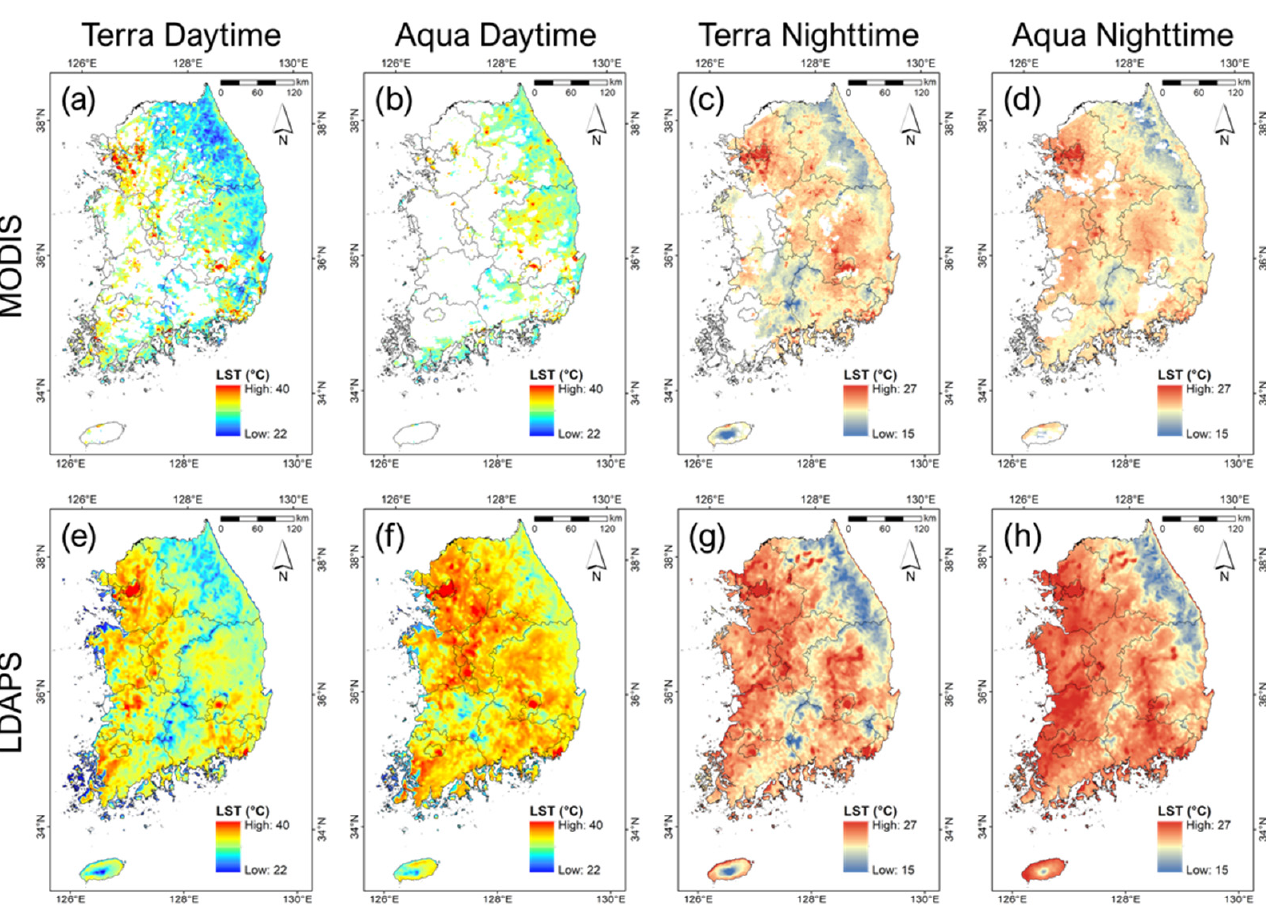
Figure 9. Spatial distribution of 1 km LSTs from ( a - d ) MODIS, ( e - h ) LDAPS, and ( i - l ) LightGBM for four MODIS view times (i.e., Terra and Aqua for daytime and nighttime) on 6 August 2018. 5. Discussion 5.1. Model Evaluation using MODIS LST and In Situ LSTs The performances of the LDAPS and LightGBM models during the daytime were lower than at night (Figure 3). In particular, both models showed the highest rRMSE for Aqua daytime and the lowest rRMSE for Aqua nighttime. This result is because the day- time LST becomes more unstable than the nighttime LST due to downward solar radia- tion, which causes a more heterogeneous spatial thermal distribution on the land surface in the daytime [5,37,56]. Unlike the proposed model, LDAPS showed a significant perfor- mance difference between day and night of up to 2 °C RMSE . LDAPS has a spatially smoothed thermal distribution due to the surface properties roughly considered in the model [57–59], which may result in a high error during the daytime with a relatively high spatial variation in the thermal distribution.